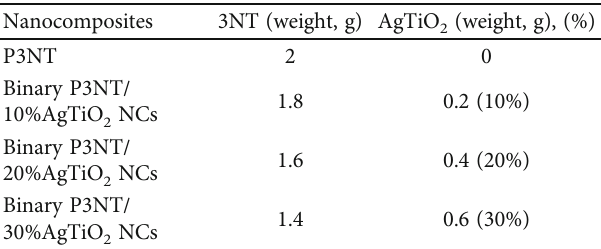
Scheme 2: Illustration of the preparation of the binary P3NT/AgTiO AgTiO NCs. 2 Table 1: The chemical compositions for P3NT/AgTiO